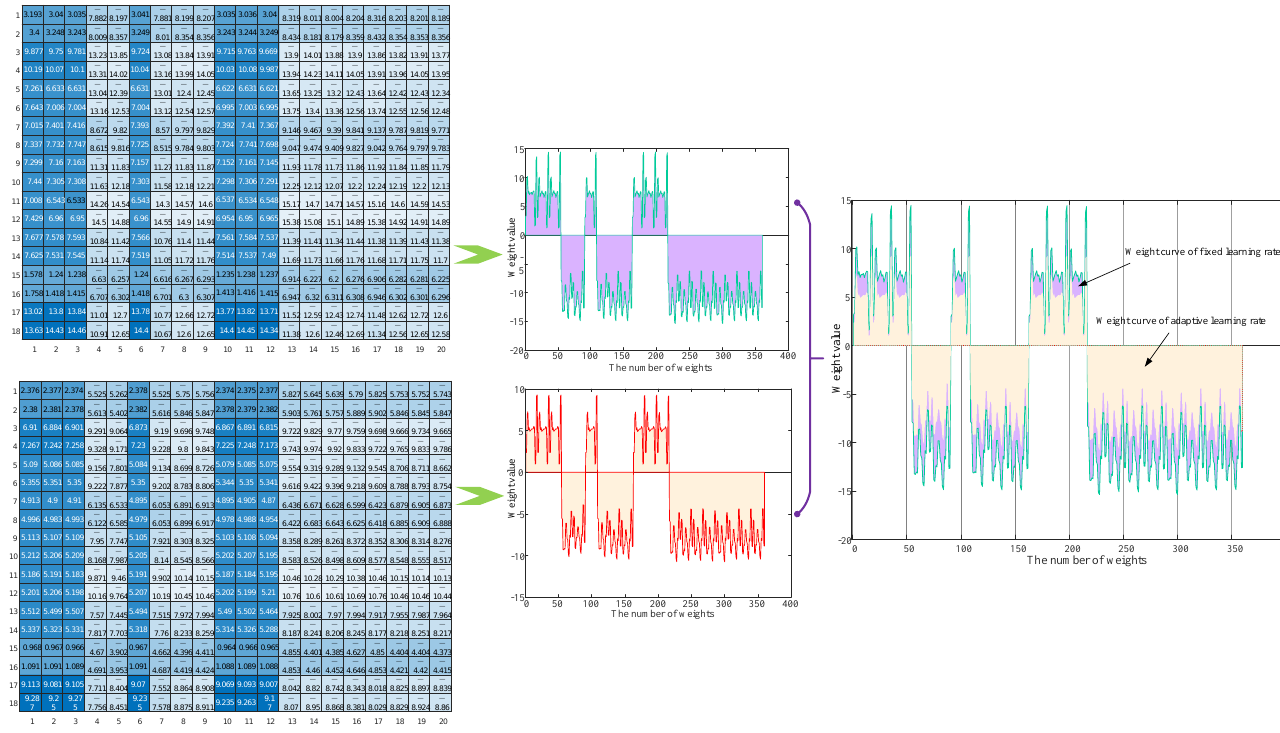
Figure 8. Comparison of optimization weights of different learning rates. Table 2. Diagnostic accuracies of different fixed learning